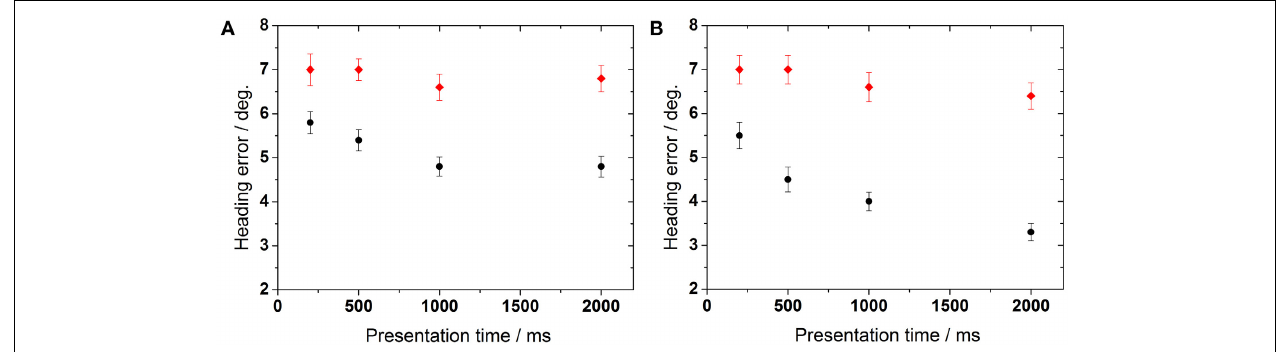
FIGURE 7 | Influence of presentation time on heading performance. The left panel (A) represents data obtained during non-stereoscopic stimulation, right panel (B) shows data obtained during stereoscopic stimulation.